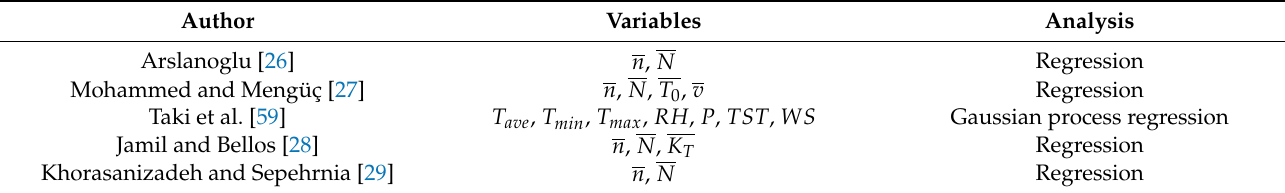
Table 3. Empirical models of the exergy of solar